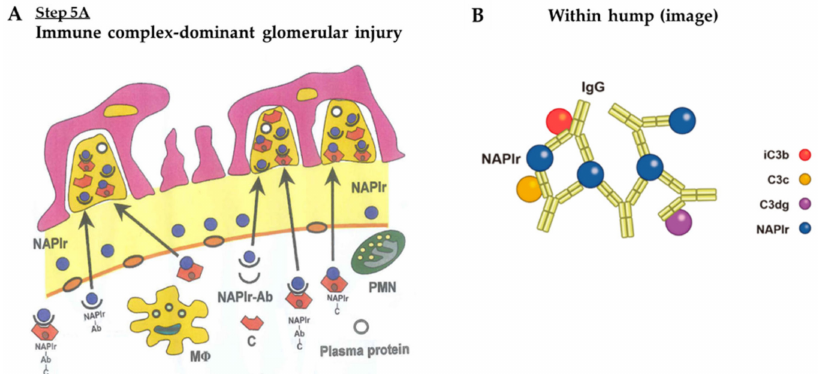
Figure 12. ( A ) Immune complex-dominant glomerular injury. ( B ) NAPlr is fully saturated with IgG and complement components, however, IgG is not saturated with complement components. NAPlr: nephritis-associated plasmin receptor, NAPlr-Ab: NAPlr-antibody complex, NAPlr-Ab-C: NAPlr-antibody-complement complexes, M Φ : macrophage, PMN: polymorphonuclear neutrophil,